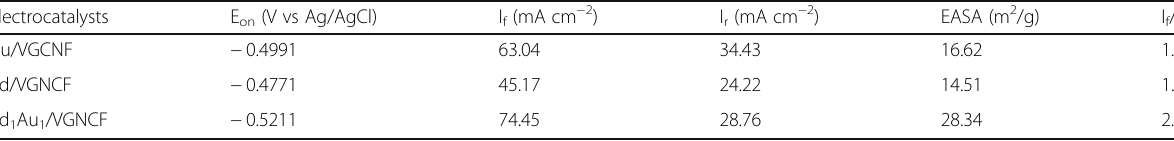
Table 3 Electrochemical analysis evaluations by cyclic voltammetry study Electrocatalysts E on (V vs